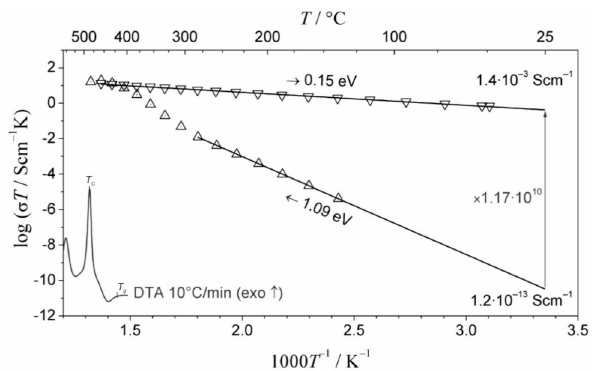
Figure 13. Dependence of electrical conductivity of Li(Fe 1–x Mn x ) 0.88 V 0.08 PO 4 (x = 0.5) sample upon heating to 480 ◦ C and subsequent cooling to room temperature. DTA trace of the material is shown in the inset. (Reproduced with permission from ref. [49]. Copyright 2017, The Electrochemical